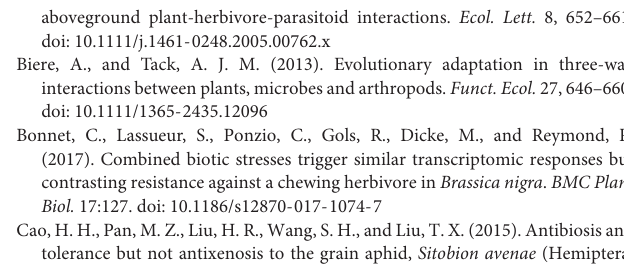
FIGURE S1 | Expression profiles of LOX among the four